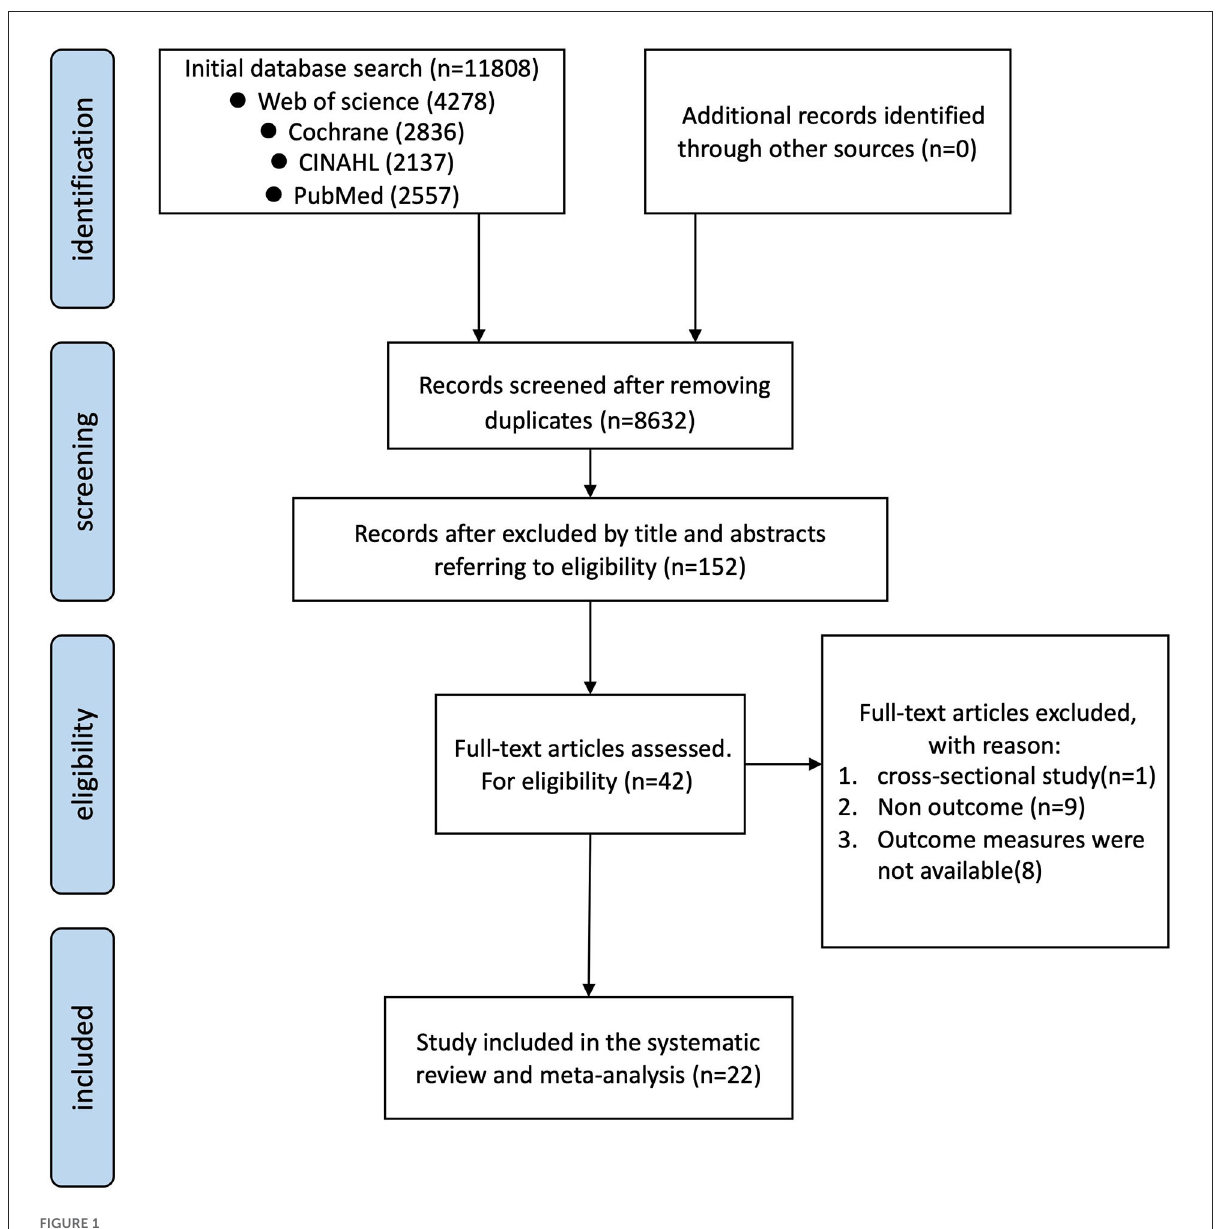
FIGURE1 Flowchart of literature search and